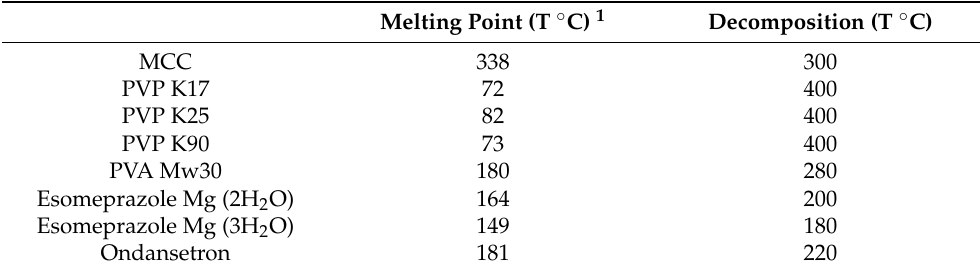
Table 3. Melting temperature and thermal stability of raw materials as determined by STA analysis.